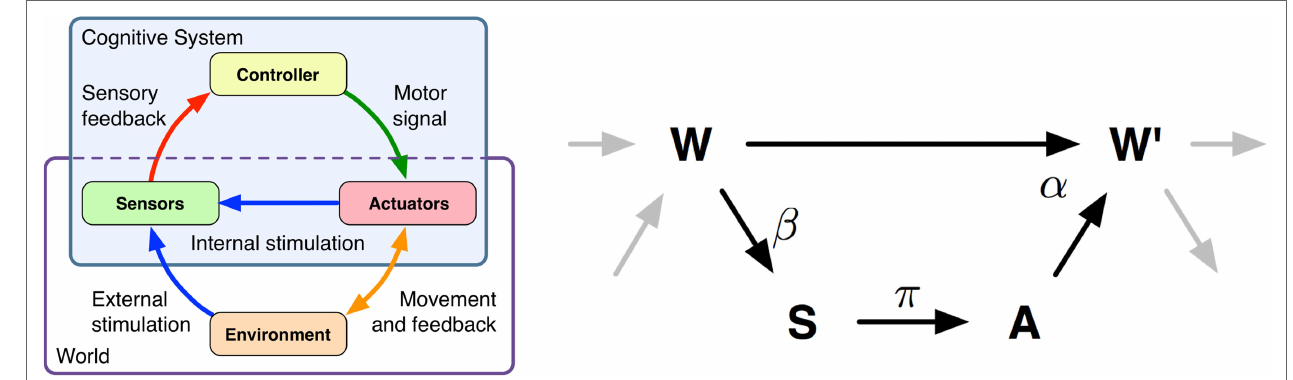
FIGURE 1 | Left-hand side: Schematics of a cognitive system and the interactions of sensors, brain, actuators, and environment . Right-hand side: Causal model of the sensorimotor loop for a reactive system (no internal state). This figure depicts a single step of an embodied, reactive system’s sensorimotor loop. The state of the world, sensors, and actuators are modeled by the random variables W , S , and A . The arrows between the variables depict the causal relations. The Greek letters denote the corresponding kernels. The sensor kernel (cid:12) ( s | w ) determines how the agent senses the world. The policy is given by (cid:25) ( a | s ), and finally the world dynamics kernel (cid:11) ( w ′ | w , a ) determines how the next world state W ′ depends on the previous world state W and action A . A detailed explanation is given in Section 2.